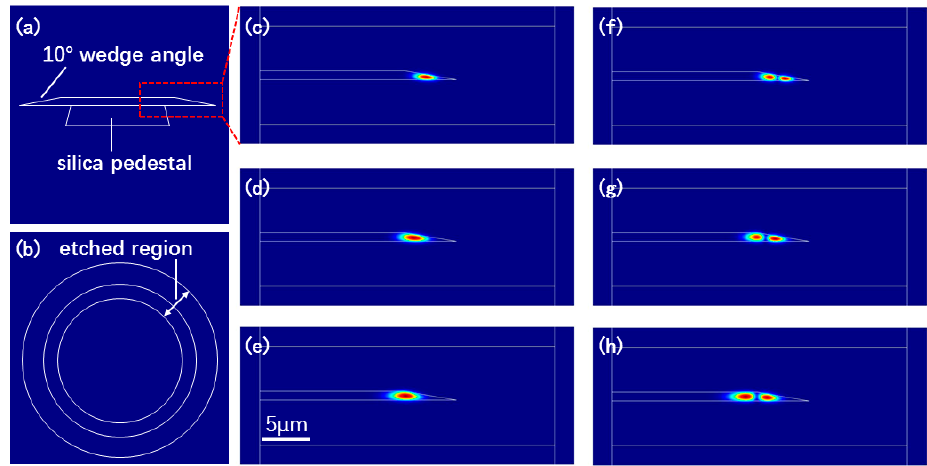
Figure 4. Side view ( a ) and top view ( b ) of the structure of the simulated microdisk resonator. Electric field of the fundamental modes in the microdisk resonator with a diameter of ( c ) 50 μ m, ( d ) 100 μ m, and ( e ) 200 μ m. Electric field of second-order modes in the microdisk resonator with a diameter of ( f ) 50 μ m, ( g ) 100 μ m, and ( h ) 200 μ m. The modes show a general feature where the mode size becomes larger with the increasing order of mode.